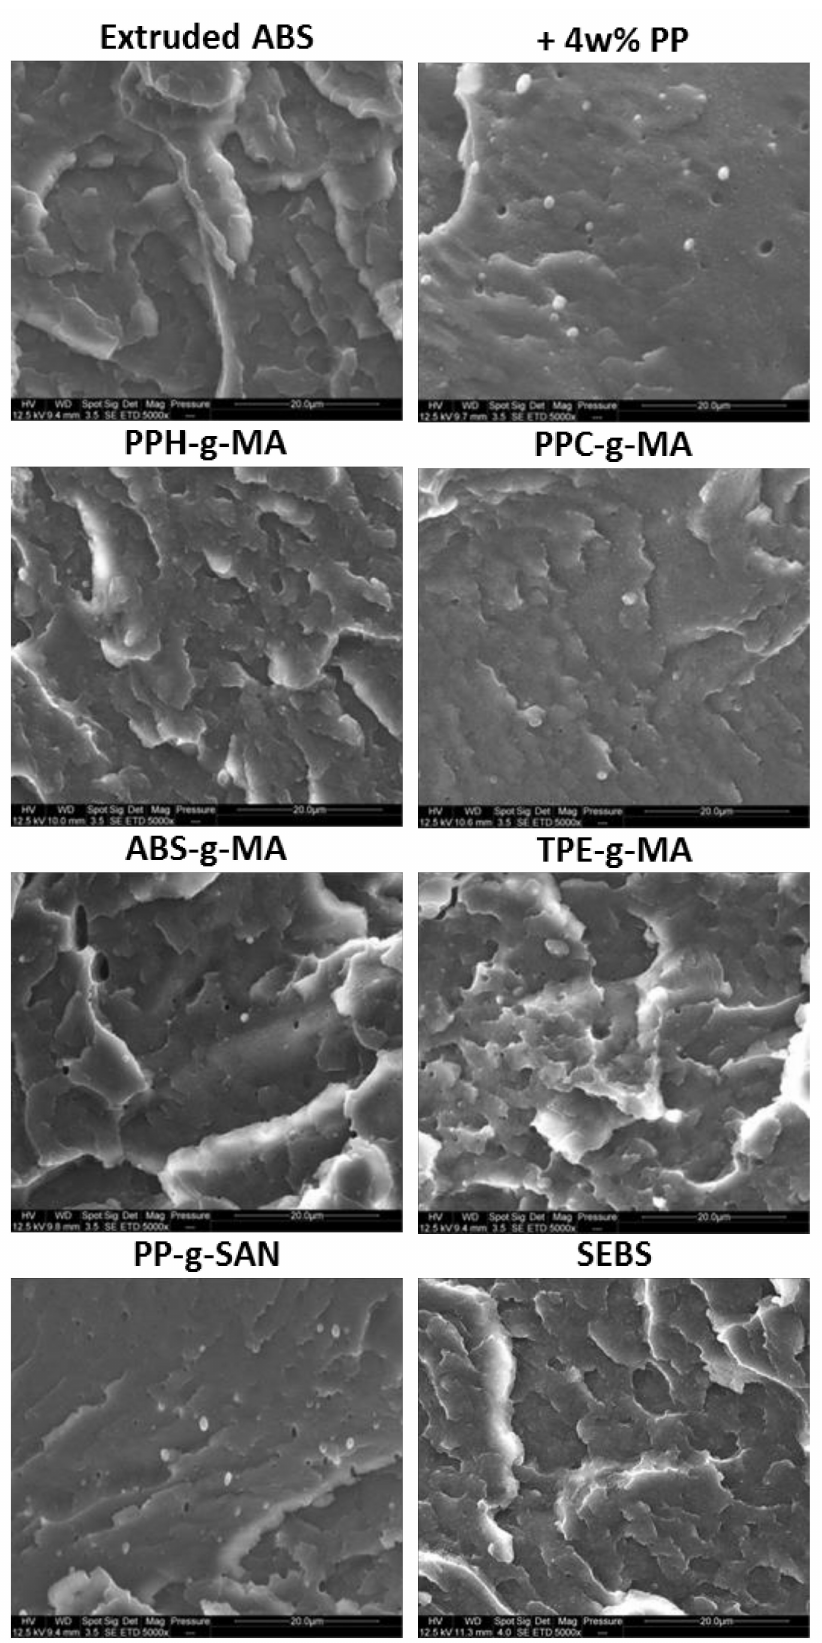
Figure 12. SEM pictures of cryofractuted dogbones—effect of compatibilizers at 3 phr on a 4 wt% PP contamination—5000 ×